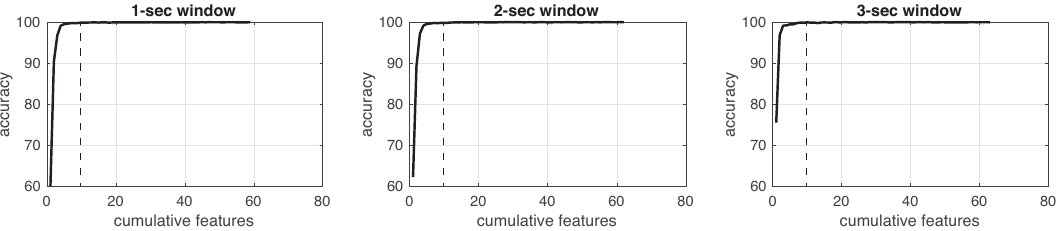
Figure 8. Accuracy performance on training using cumulative features for Experiment 1 : IR. From left to right, it presents the performance using: 1-second length windowing, 2-second length windowing and 3-second length windowing. The dash line reports the number of cumulative features employed for the next steps.